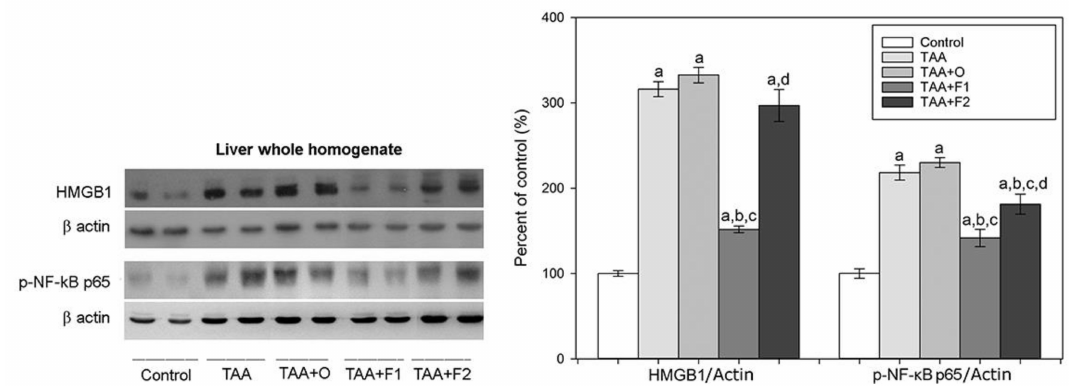
Figure 4. Protein expression levels of HMGB1 and phospo-NF-kB p65 in whole liver homogenates in control, and rats treated with thioacetamide (TAA), thioacetamide + virgin olive oil (TAA+O), thioacetamide + C60 fullerene lower dose (TAA+F1), and thioacetamide + C60 fullerene higher dose (TAA+F2). Data are given as mean ± standard error. Minimal significance level: p < 0.05. Significantly different: a in respect to Control; b in respect to TAA; c in respect to TAA+O, and d in respect to TAA+F1 group. The number of animals per group =